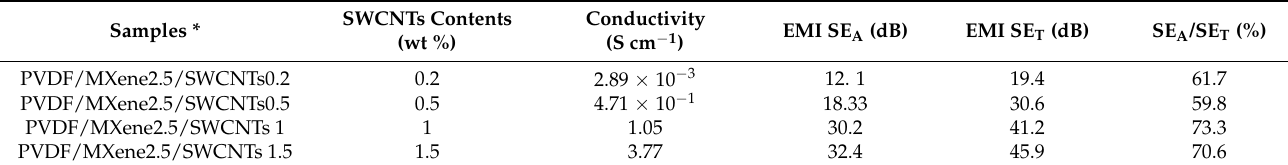
Table 2. Conductivity, EMI shielding , and SE A /SE T according to the SWCNTs contents.